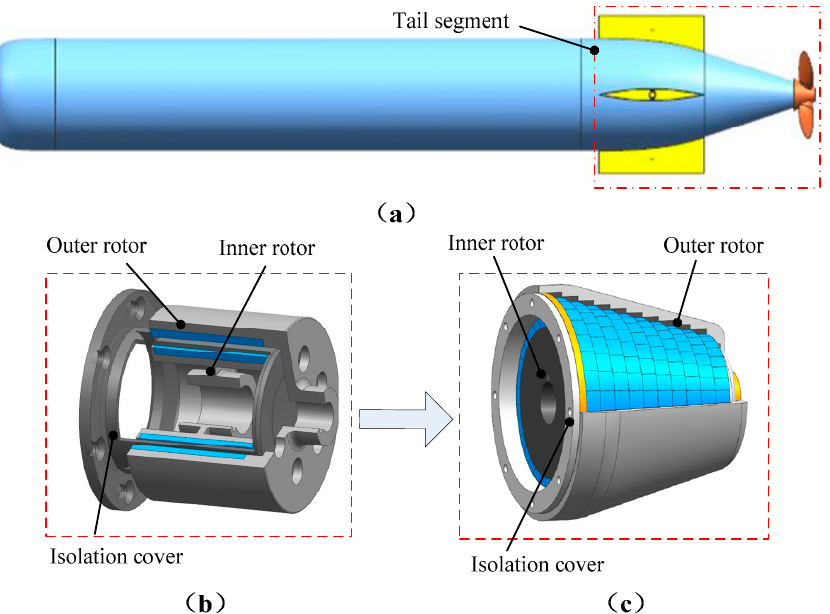
Figure 1. Underwater vehicle and propulsion unit. ( a ) Tail segment. ( b ) Radial permanent magnet coupling (PMC). ( c ) Novel conical Halbach permanent magnet coupling (C-HPMC).